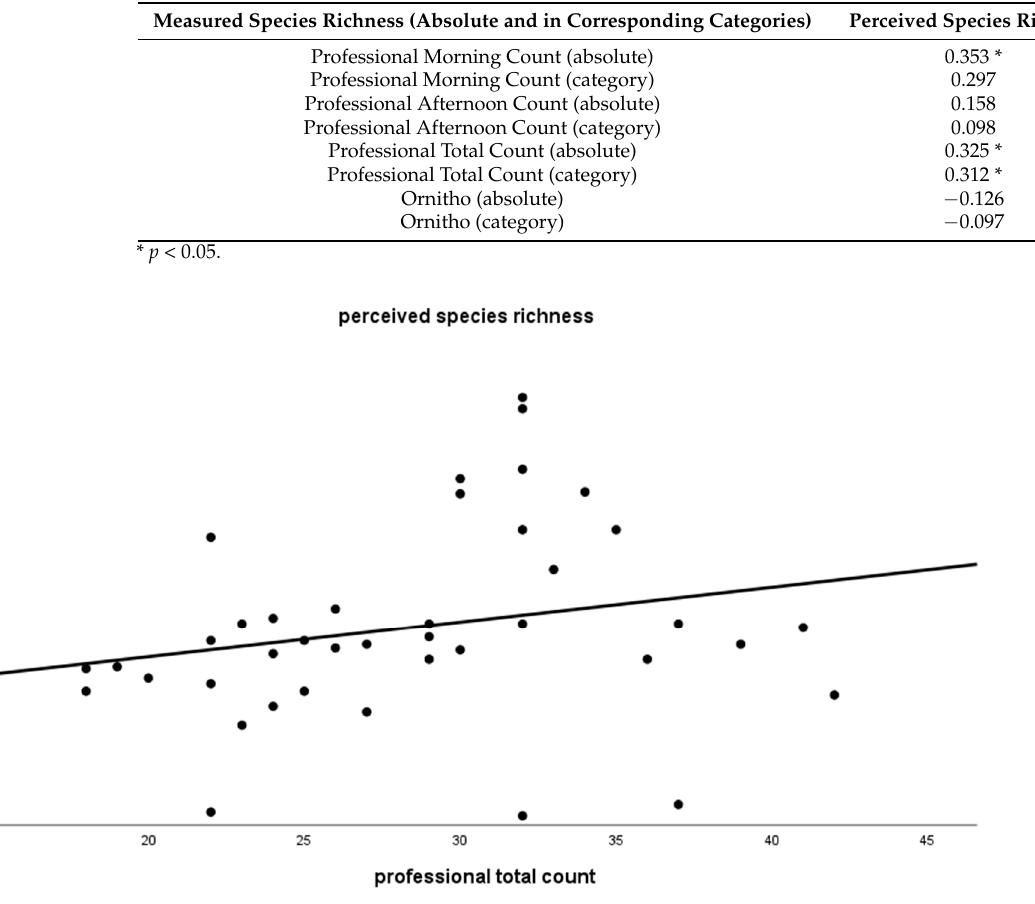
Figure 1. Perceived species richness of laypeople (measured in categories, averaged per place) correlated with the professional total count (measured in absolute numbers).